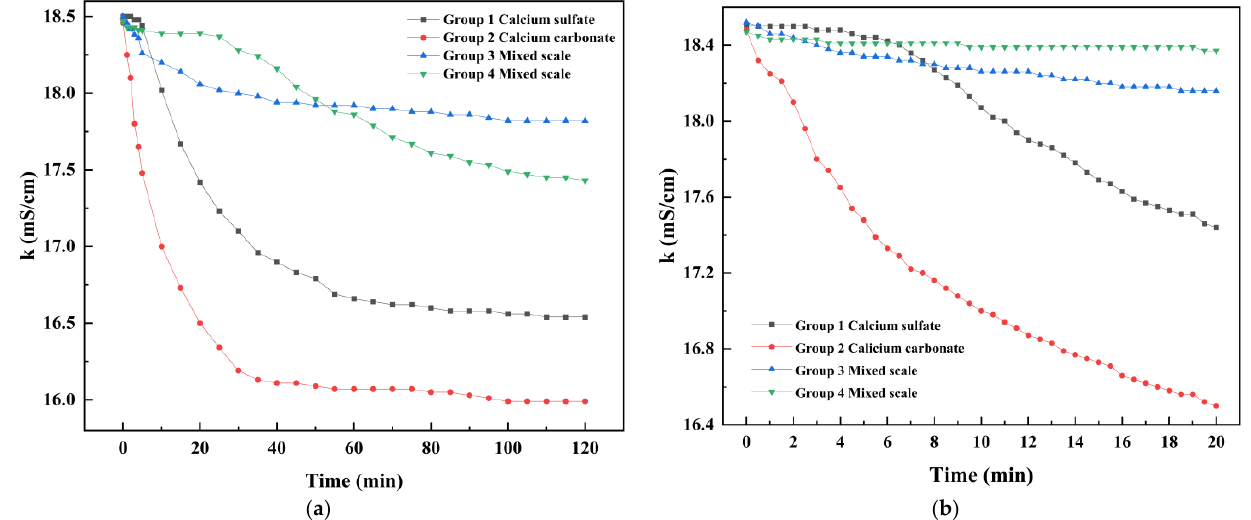
Figure 2. The variation curve of conductivity of solution with time, ( a ) in 120 min; ( b ) first 20 min.